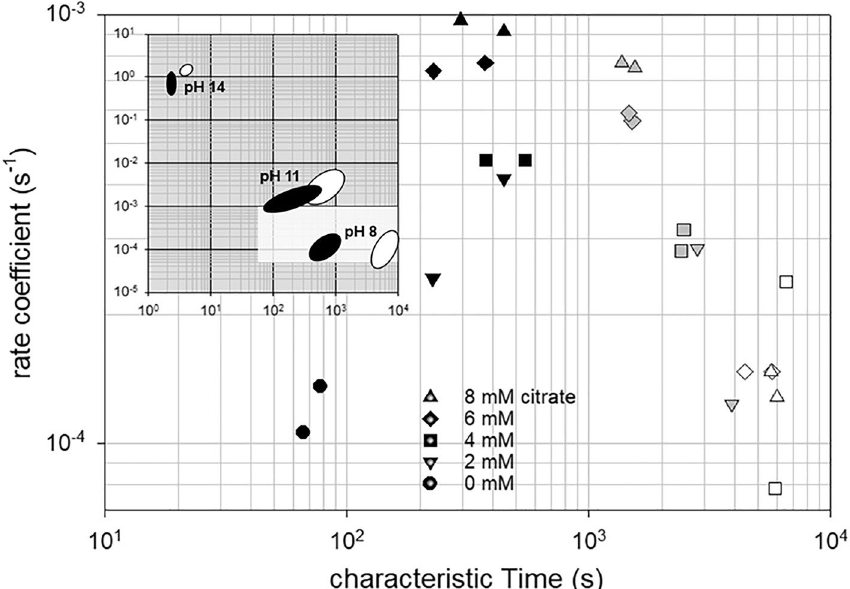
Figure 4. Swelling coefficients as a function of their characteristic start times for the first step (closed symbols) for the subsequent slowed phase (grey symbols) and for the second step (open symbols) of swelling of CMPs at pH 8.0 prepared without or with different citrate concentrations. The insert shows how the location of the parameter pairs for the first and second swelling steps of CMPs without citrates (black and white areas) changes as a function of pH (reconstructed from Schulte 30